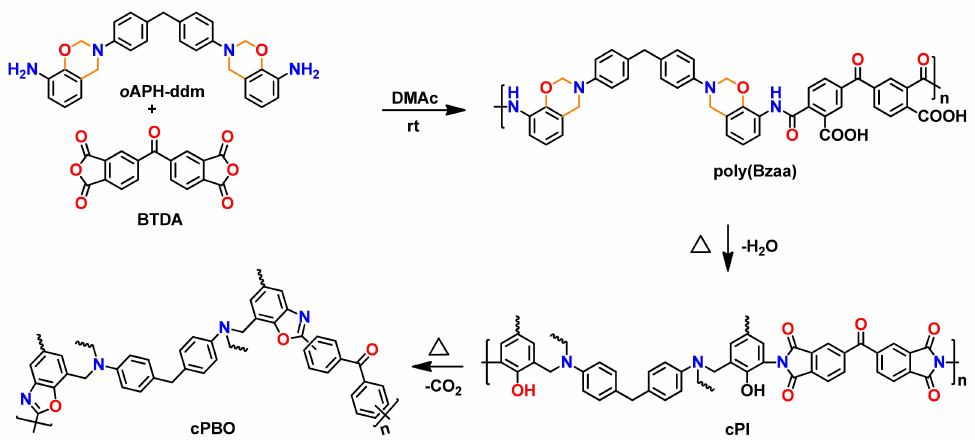
Figure 27. Preparation of cPBO via poly(Bzaa) from benzoxazine monomer [241].